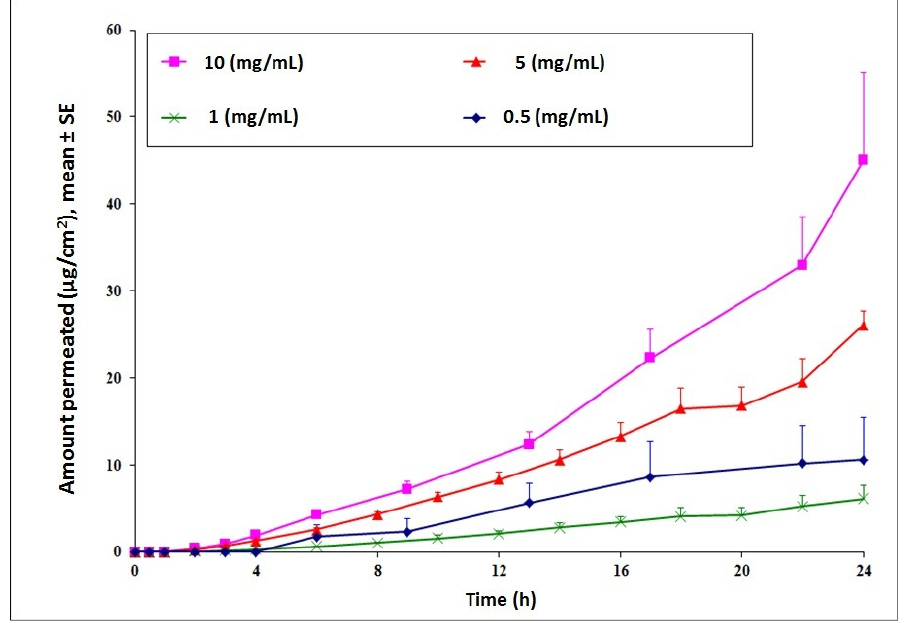
Figure 1. Effect of donor concentration on cyanocobalamin delivery. Passive permeation of cyanocobalamin indicated a concentration dependent delivery with maximum delivery at 10